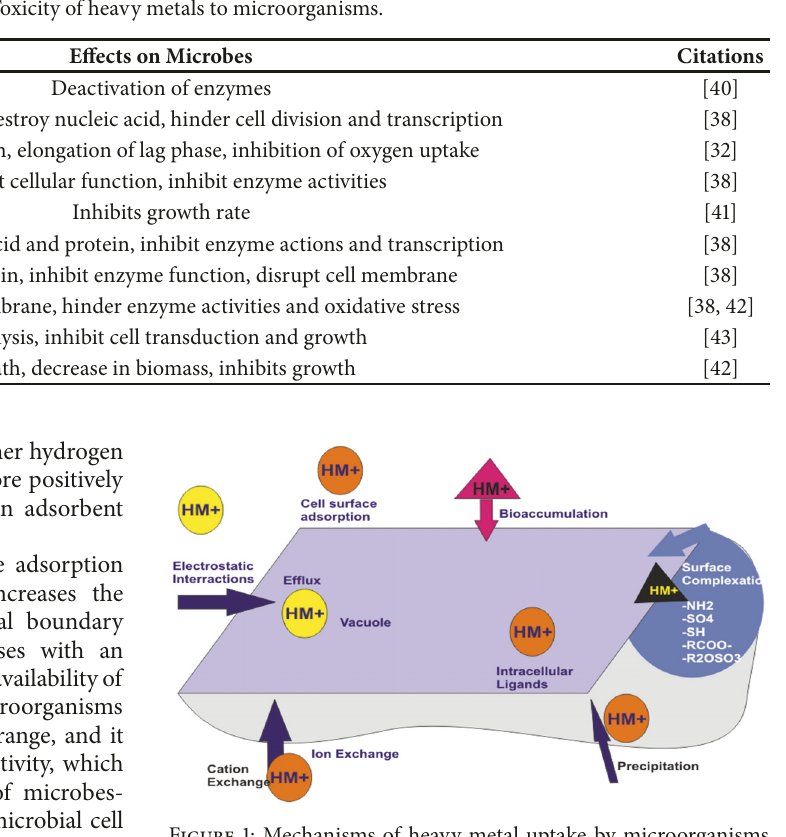
Figure 1: Mechanisms of heavy metal uptake by microorganisms [47,